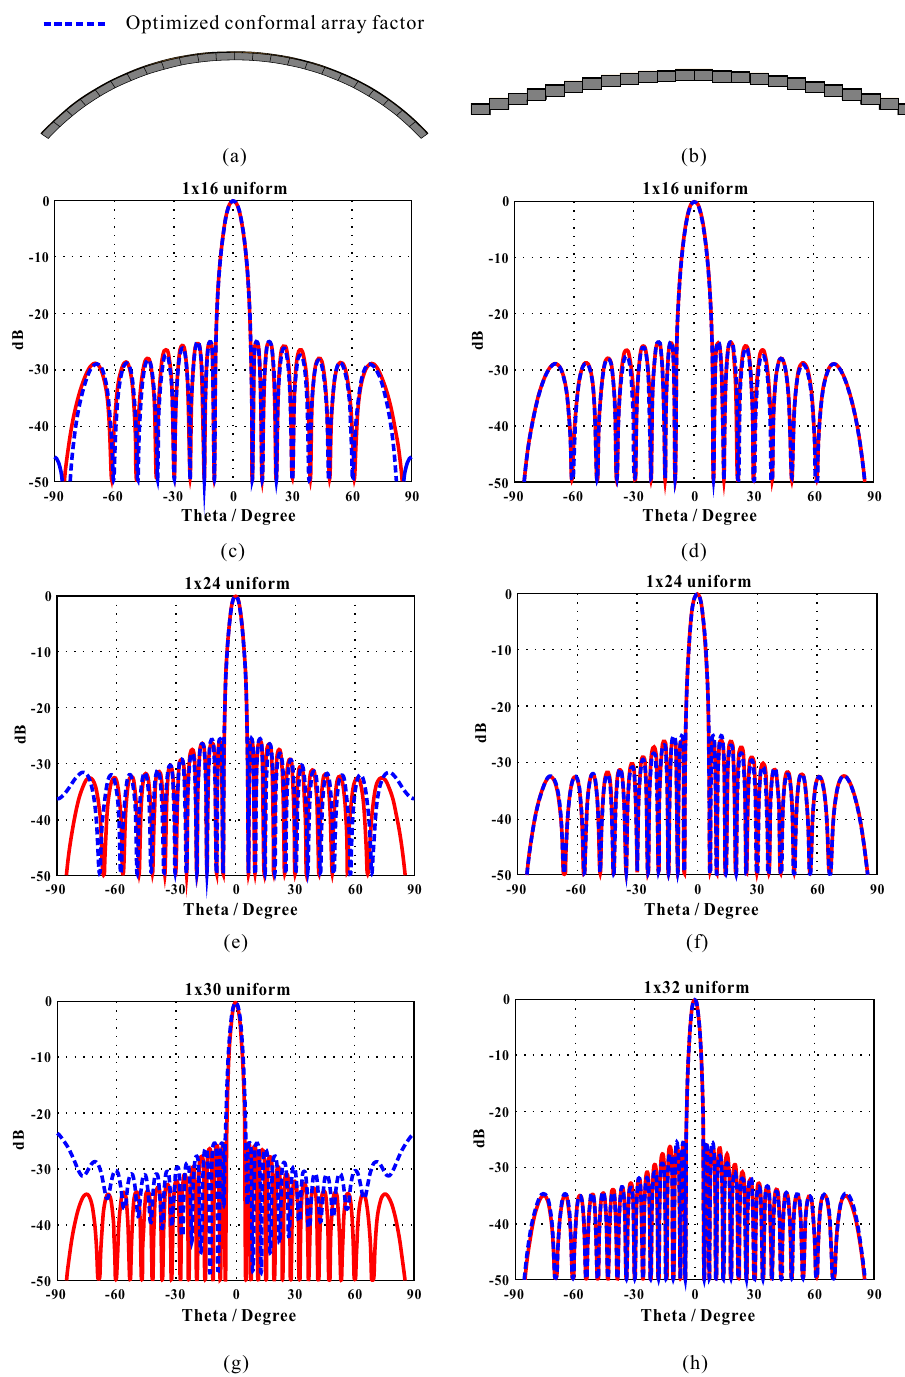
Figure 9. Array factors ( − 25 dB) of conformal array optimized based on GLPSO: ( a ) conformal array type 1; ( b ) conformal array type 2; comparison of radiation patterns of ( c ) 1 × 16 conformal array type 1 and 1 × 16 planar array, ( d ) 1 × 16 conformal array type 2 and 1 × 16 planar array, ( e ) 1 × 24 conformal array type 1 and 1 × 24 planar array, ( f ) 1 × 24 conformal array type 2 and 1 × 24 planar array, ( g ) 1 × 30 conformal array type 1 and 1 × 30 planar array, and ( h ) 1 × 32 conformal array type 2 and 1 × 32 planar